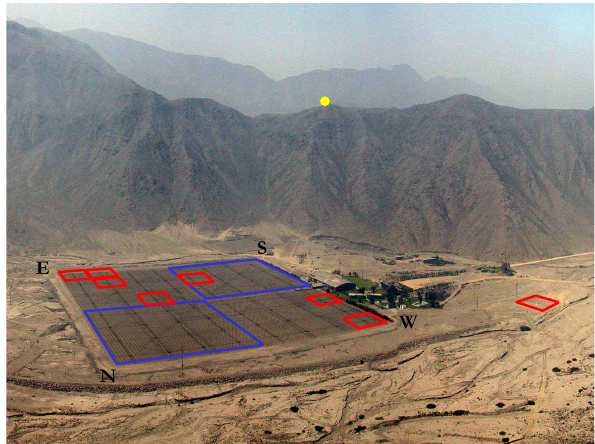
Fig. 1. Example of a radar imaging configuration at Jicamarca using 8 receiving antennas (in red). The transmitting antenna is denoted in blue. For this particular example, all the possible antenna sep- arations are non-redundant in the zonal (east-west) direction. The yellow circle represents the location of the radio beacon on one of the